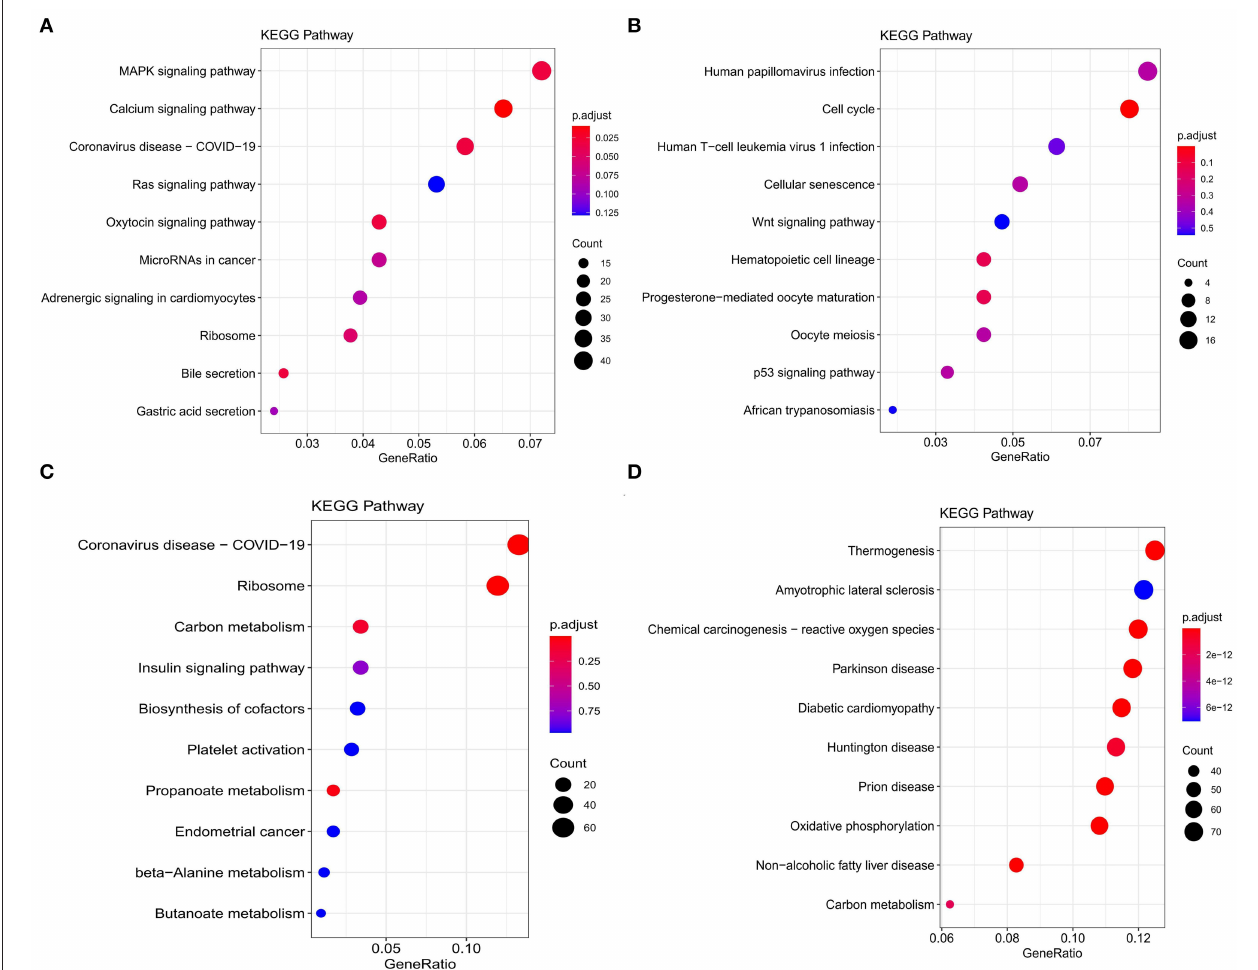
FIGURE 4 | Kyoto Encyclopedia of Genes and Genomes (KEGG) functional enrichment analysis of modules that are most associated with nutrient levels. In subcutaneous adipose tissue, genes from the blue and yellow modules that significantly related to low nutrition (A) , and high nutrition (B) were analyzed. In visceral adipose tissue, genes from the blue and brown modules that significantly related to low nutrition (C) , and high nutrition (D) were analyzed. The top 10 significantly enriched pathways were